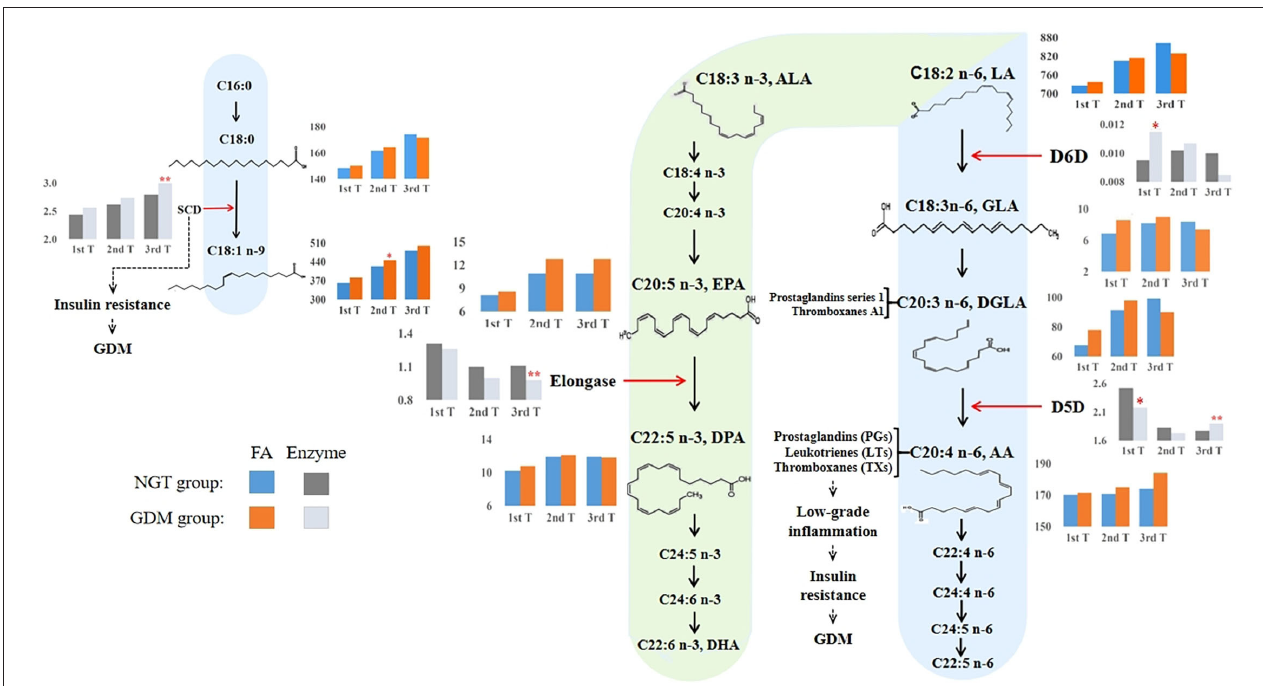
FIGURE 4 | Overview of proposed GDM mechanisms based on how the long-chain fatty acid levels and estimated desaturase activities differed between GDM and NGT participants across trimesters. The n-3 and n-6 PUFA metabolic pathways ( 20, 38, 39) illustrated how high estimated D6D activity and low estimated D5D activity contributed to the early development of GDM. Conversely, higher estimated D5D activity was associated with a higher risk of GDM in the third trimester of pregnancy. The estimated desaturase activities of the maternal serum indicated a dysregulation of PUFA. In particular, the level of AA was increased throughout pregnancy in the GDM group. AA, as a precursor of pro-inflammatory eicosanoids (e.g., prostaglandins, thromboxanes, and leukotrienes), was associated with insulin resistance. Moreover, we also found that estimated SCD (delta-9–18 desaturase) activity increased significantly during pregnancy in women with GDM, promoting insulin resistance. Based on these observations, we hypothesize that dyshomeostasis of PUFAs caused by impaired D6D, D5D, and SCD activities may contribute to low-grade inflammation, subsequently advancing insulin resistance and the pathophysiology of GDM. 1st T, first trimester, 11–14 weeks; 2nd T, second trimester, 22–28 weeks; 3rd T, third trimester, 32–34 weeks; GDM, gestational diabetes mellitus; NGT, normal glucose tolerance; FA, fatty acid; C18:0, octadecanoic acid; C18:1n-9, octadecenoic acid; C18:2n-6, linoleic acid (LA); GLA, γ -linolenic acid; DGLA, eicosatrienoic acid; AA, arachidonic acid; C18:3n-3, α -linolenic acid; EPA, eicosapentaenoic acid; DPA, docosapentaenoic acid; SCD (stearoyl-CoA desaturase), C18:1n-9/C18:0; D6D, delta-6 desaturase, C18:3n-6/C18:2n-6; D5D, delta-5 desaturase, C20:4n − 6/C20:3n − 6; elongase, C22:5n-3/C20:5n-3. **: p , q < 0.01; *: p , q < 0.05. Blue and orange bars indicate the absolute concentrations of